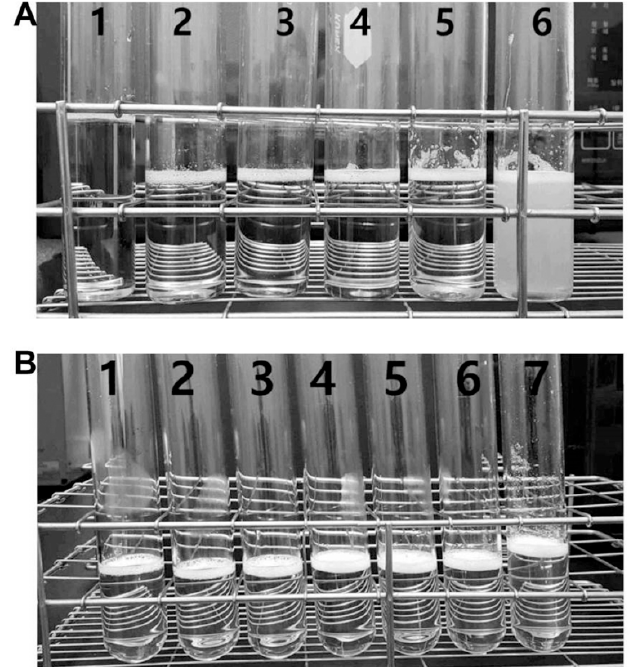
Figure 4. Physical examination of the aqueous YSB201 formulation under various pH condition. ( A ) For the formulation with the weight ratio of ursodeoxycholic acid (UDCA) to maltodextrin (1:15), the solution in tubes is displayed with numbers at different pH conditions; pH 9.5 ( 1, clear ), pH 8.9 ( 2, clear ), pH 7.9 ( 3, clear ), pH 7.1 ( 4, clear ), pH 6.0 ( 5, clear ), pH 5.5 ( 6, precipitated ). ( B ) With the weight ratio of UDCA to maltodextrin (1:30), the solution in tubes is displayed with numbers at different pH conditions; pH 9.0 ( 1, clear ), pH 8.0 ( 2, clear ), pH 7.0 ( 3, clear ), pH 6.0 ( 4, clear ), pH 5.1 ( 5, clear ), pH 4.1 ( 6, clear ), pH 2.9 ( 7, clear ). Pharmaceutics 2019 , 11 , x FOR PEER REVIEW